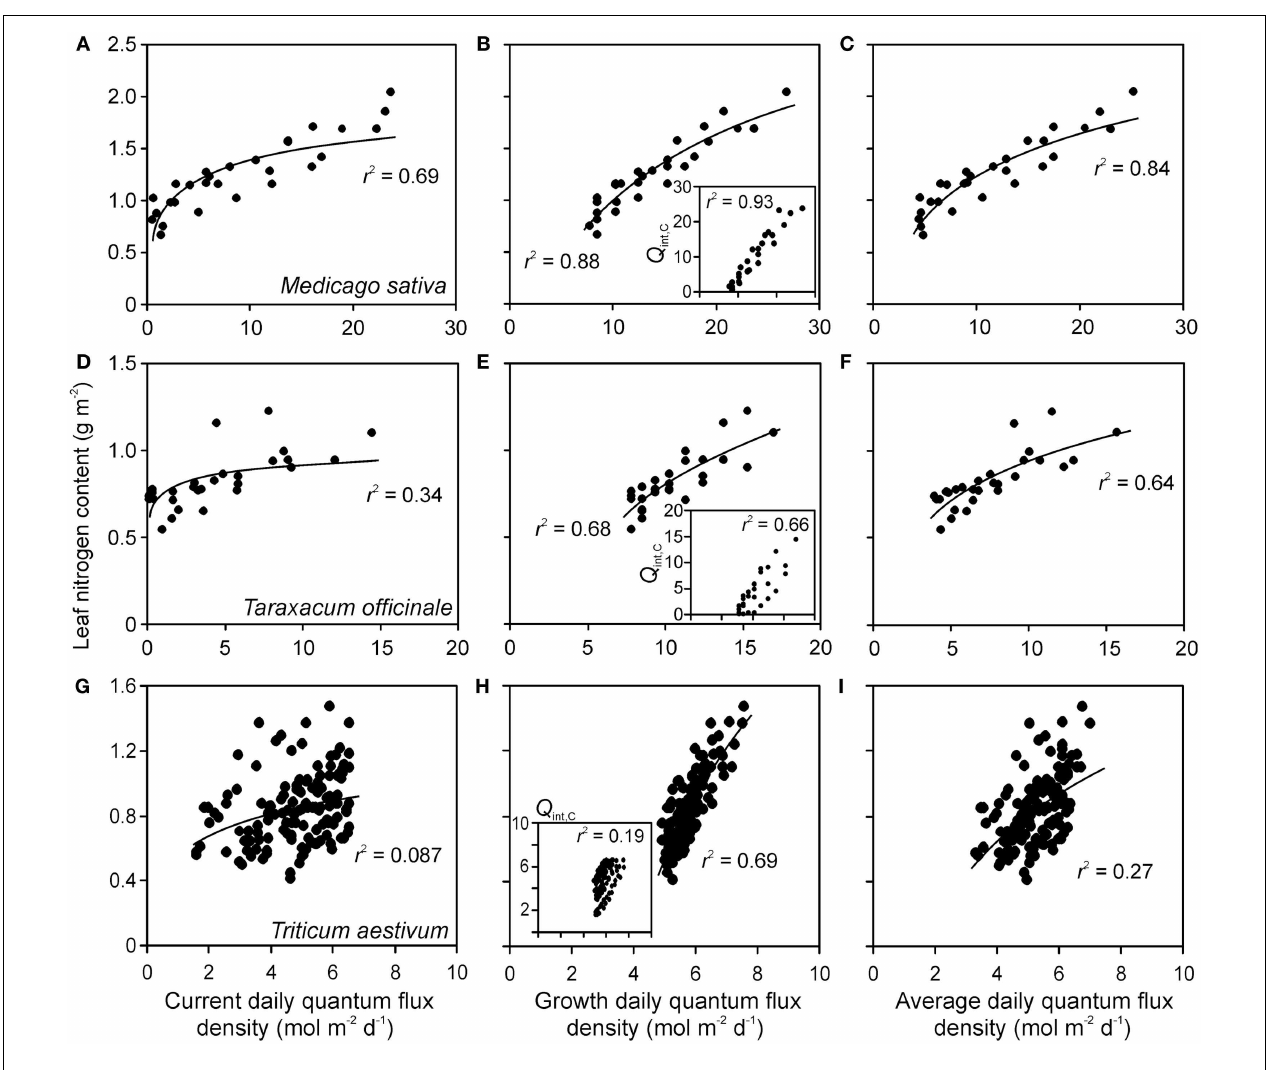
the data were pooled. Insets in (B,E,H) demonstrate the correlations between Q int,C and Q int,G . Data were fitted by non-linear regressions in the form of y = a Ln( x ) + b , that generally provided the highest degree of explained variance ( r 2 ), except for the insets, where r 2 values for linear regressions are provided (all regressions are significant at P < 0.001). Details of calculation of Q int,G are provided in Material and methods (see Estimation of dynamic changes in light profiles in growth chambers and Estimation of Changes in Light Profiles for Studies with Combined Natural and Supplemental